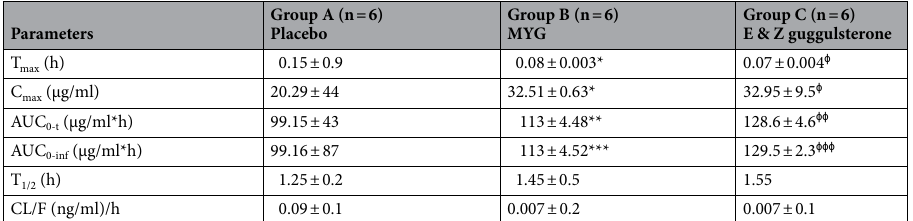
Table 3. Pharmacokinetic parameters of alpha hydroxy midazolam in rat plasma. Values are expressed in mean ± SD; (*) P < 0.05 Group A vs Group B; ( ɸ ) P < 0.05 Group A Vs Group C. T max time required to achieve total body clearance; t½ half-life.